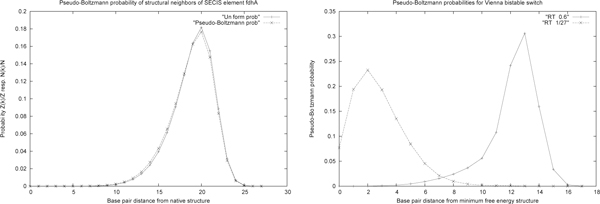
(Left) Pseudo-Boltzmann and uniform probabilities of structural neighbors MEA(k) for the 49 nt SECIS sequence fdhA, with nucleotide sequence CGCCACCCUG CGAACCCAAU AAUAAAAUAU ACAAGGGAGC AAGGUGGCG and where S0 is (((((((.(((...(((.................))).))).))))))). Here, the (formal) parameter RT taken to be 49 (length of sequence), in order to uniformize MEA scores to range between 0 and 1. The pseudo-Boltzmann probability is defined by Pb(k)=Z(k)Z, where (i) Z(k) = Σexp(MEA(S)/RT), the sum being taken over all S such that dBP(S0, S) = k, and (ii) Z = ΣkZ(k). The uniform probability is defined by Pu(k)=N(k)N, where N(k) is the number of k-neighbors of S0 and N is the total number of secondary structures. (Right) Pseudo-Boltzmann probabilities for MEA(k) structural neighbors of the 27 nt Vienna bistable switch with nucleotide sequence CUUAUGAGGG UACUCAUAAG AGUAUCC and initial (minimum free energy) structure.......((((((((....)))))))). The left curve is when RT = 0.6, the approximate value obtained by multiplying the universal gas constant 0.00198 kcal/mol times 310 Kelvin. In contrast, the right curve is when RT = 27 (length of sequence). Though not shown in this graph, the pseudo-Boltzmann distribution is identical with the uniform distribution, when RT = n, where n is sequence length.